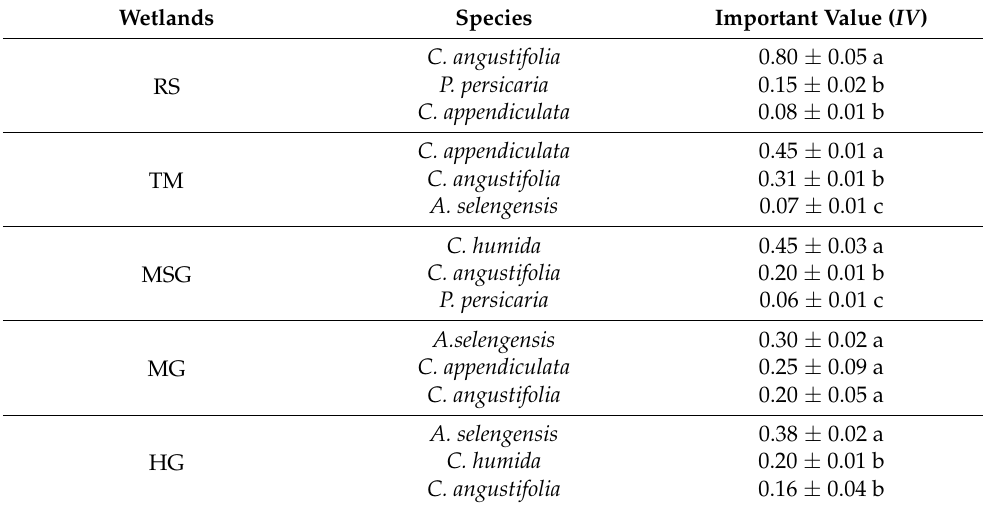
Table 1. Three major plants in wetlands under five land uses and their important values ( IV ). Wetlands